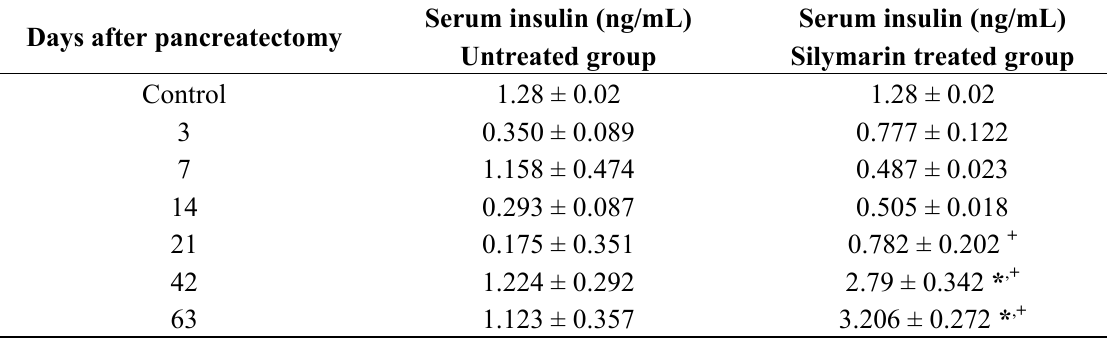
Table 1. Serum insulin levels in experimental